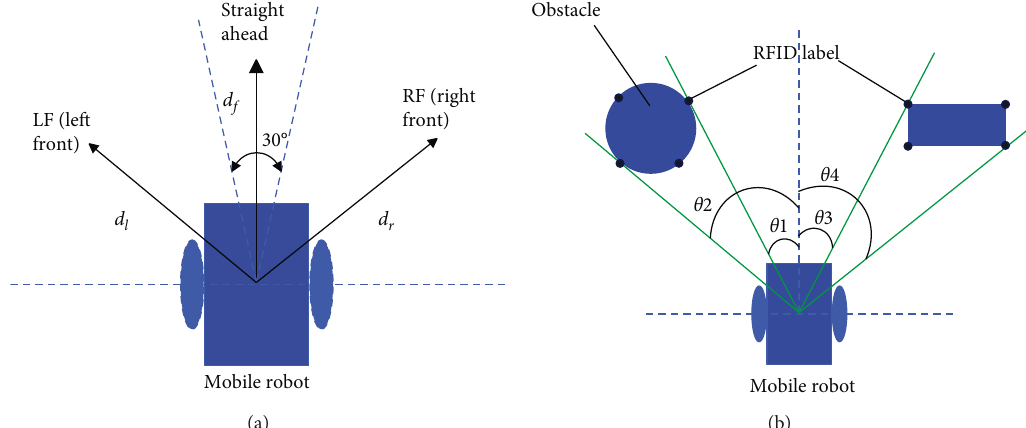
Figure 8: The division of the robot and the obstacle ahead. (a) The front orientation of the robot is divided. (b) Barrier orientation The 30 ° range in front of the robot is defined as the front, the area on the left side of the front is defined as the front left, and the area on the right is defined as the front right.